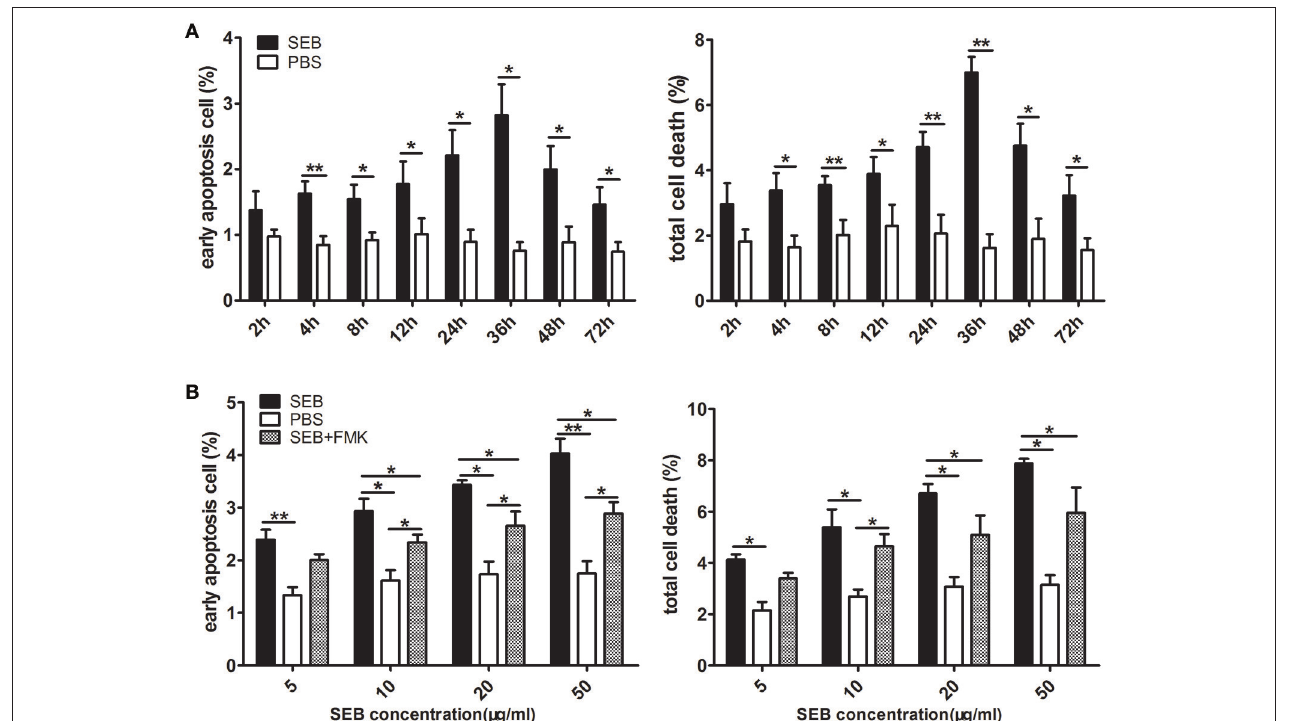
FIGURE 3 | SEB induced THP-1 cell apoptosis in a time- and dose-dependent manner. (A) THP-1 cells (2 × 10 5 per well in 24-well-plates) were treated with 20 µ g/ml (24 µ l/well) SEB (black bar) or 24 µ l/well PBS (white bar) for 2, 4, 8, 12, 24, 36, 48, and 72h. (B) THP-1 cells (2 × 10 5 per well in 24-well-plates) were pre-treated with 20 µ M (6 µ l/well) Z-VAD-FMK for 30min, and the cultures in the wells with 6 µ l of RPMI 1640 medium containing 10% ( ν / ν ) DMSO served as controls. Cells were then treated with 5, 10, 20, or 50 µ g/ml (60 µ l/well) SEB (black bar and striped bar) or 60 µ l/well PBS (white bar) for 36h. Apoptosis was measured through Annexin V/PI staining and flow cytometry. Quantitatively analyzed data are presented as means ± S.D . ( n = 4), *indicated P < 0.05, and **indicated P < 0.01.